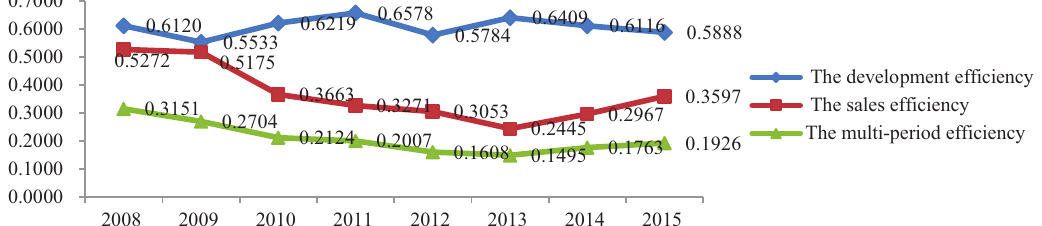
Figure 5. The average multi-period two-stage efficiency and its decompositions from 2008 to